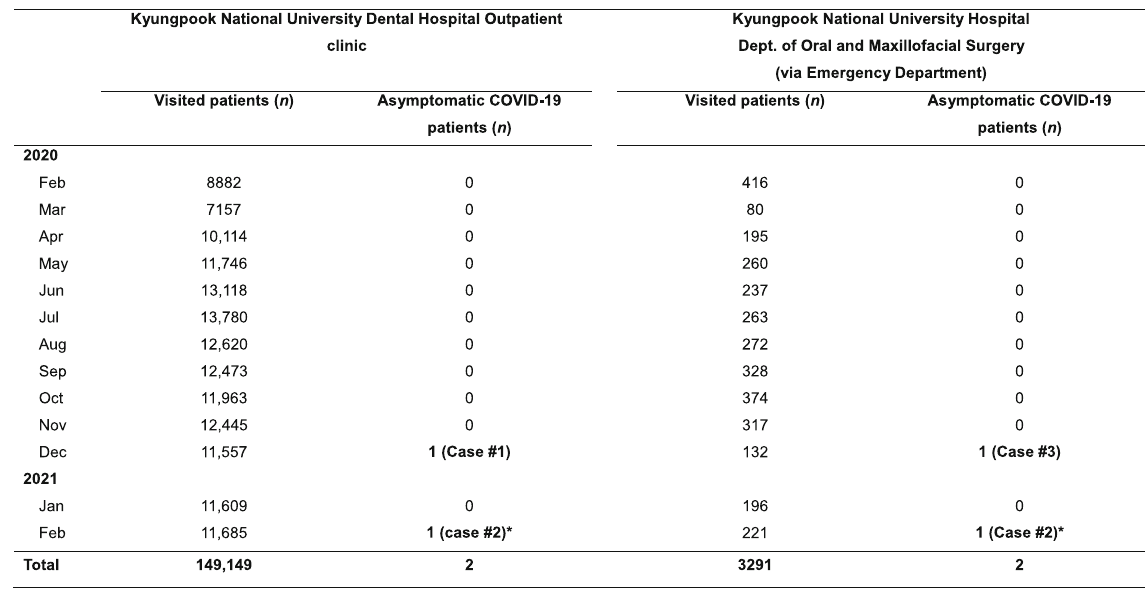
Table 1 Distribution of the study population and eligible case